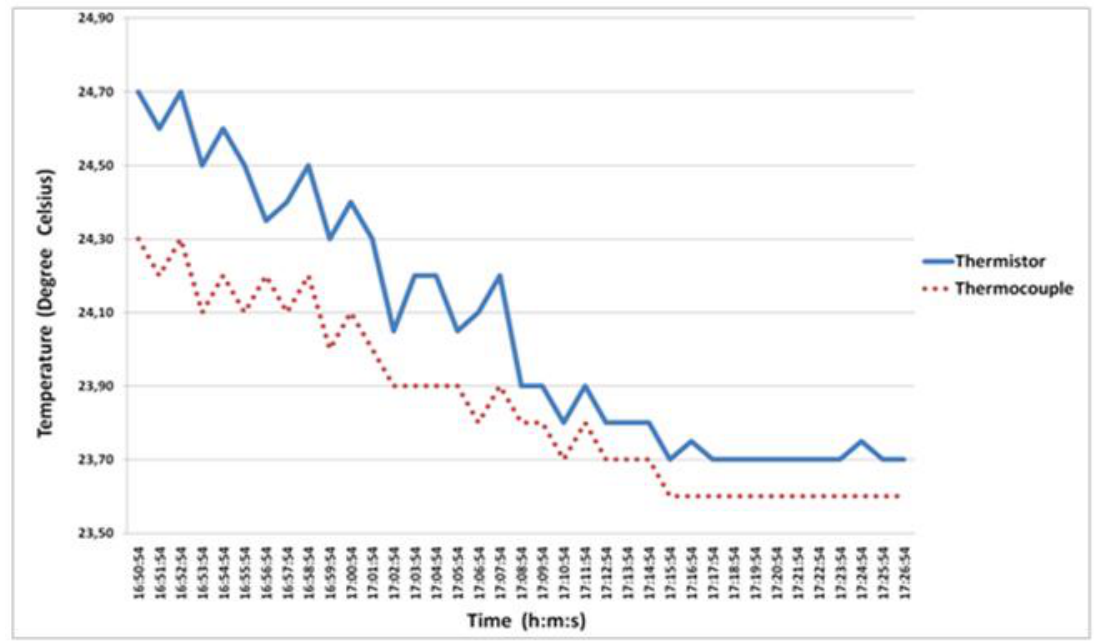
Figure 8. Performance comparison between temperature values acquired with a thermopar and a thermistor from a natural